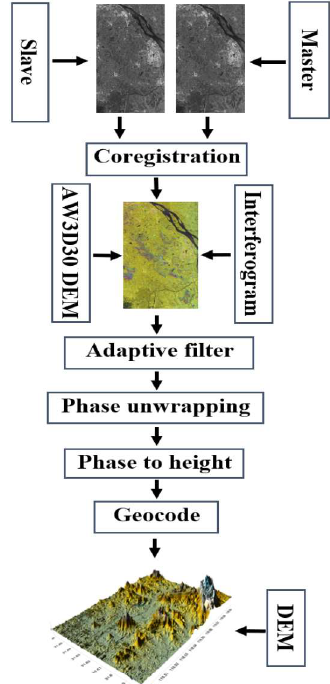
Figure 2 Technological process of extraction of DEM with high